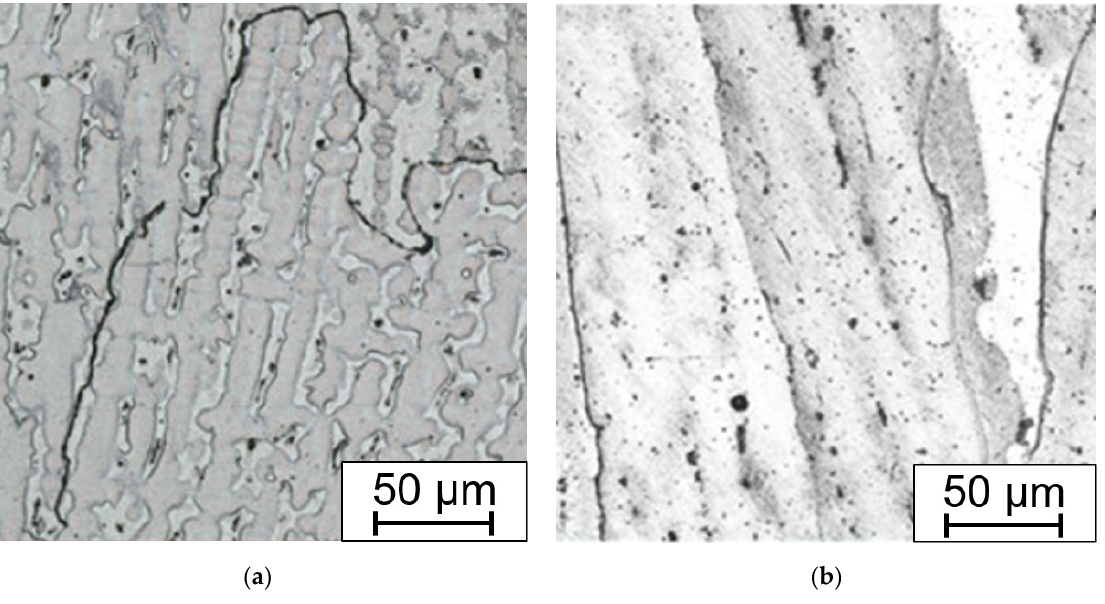
Figure 15. Microstructure of the weld metal Thermanit304Cu ( a ) after welding; ( b ) after solution annealing. Electrolytically etched in 10% aqueous acetic acid (5 V DC, 10 s).